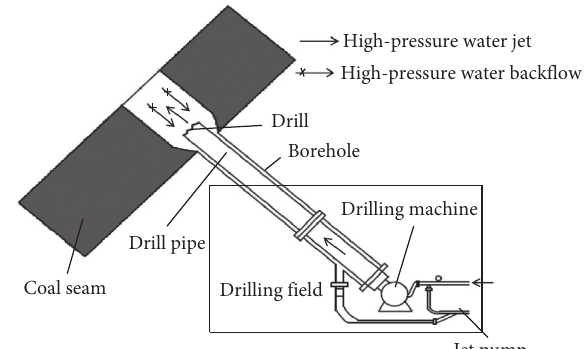
Figure 1: Schematic diagram of hydraulic punching equipment and technical